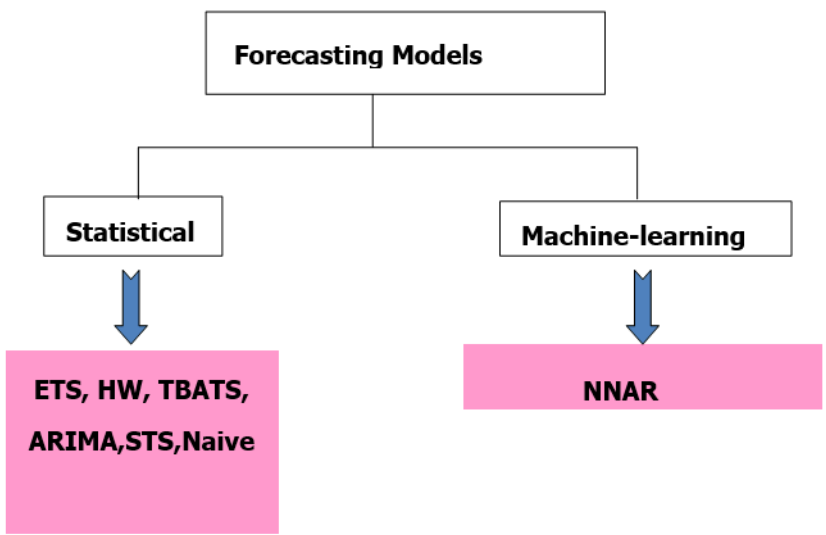
Figure 5. The holdout period forecasting method.